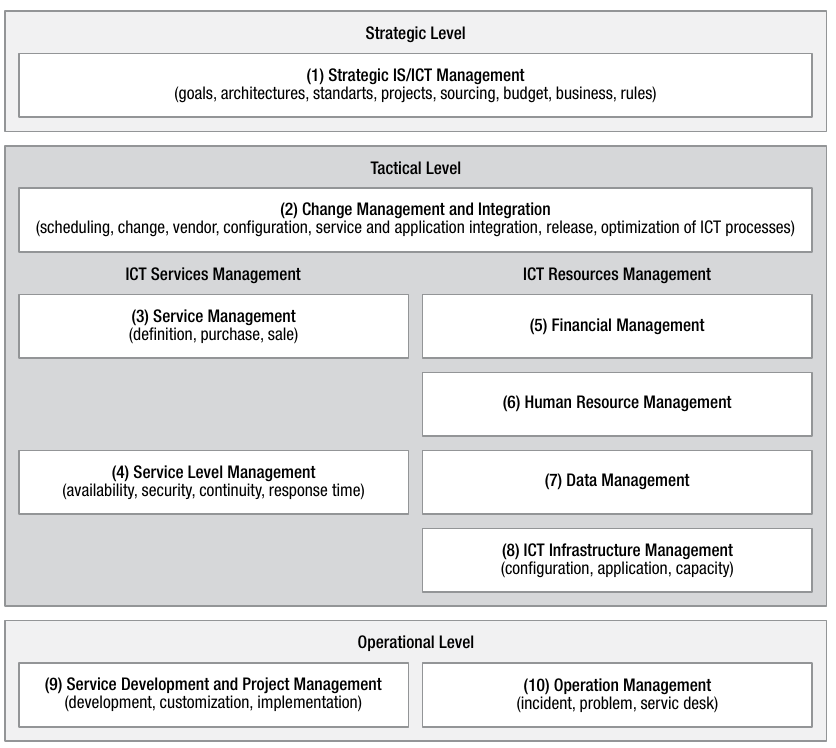
Fig. 1. Reference model of business informatics management (Novotny 2003)